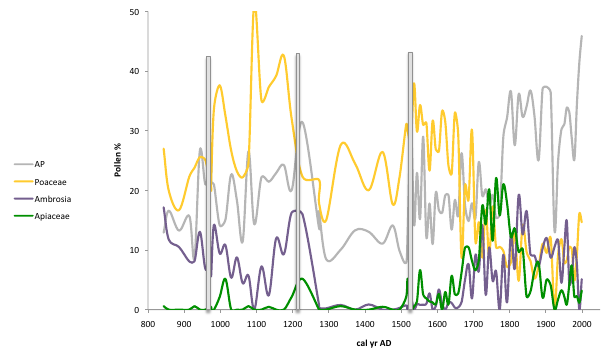
Fig. 6. Synthetic pollen diagram of core PA 1-08 showing changes in frequencies of arboreal pollen taxa, Poaceae, Ambrosia and Api- aceae presented along a timescale. Gray bars indicate volcanic erup-